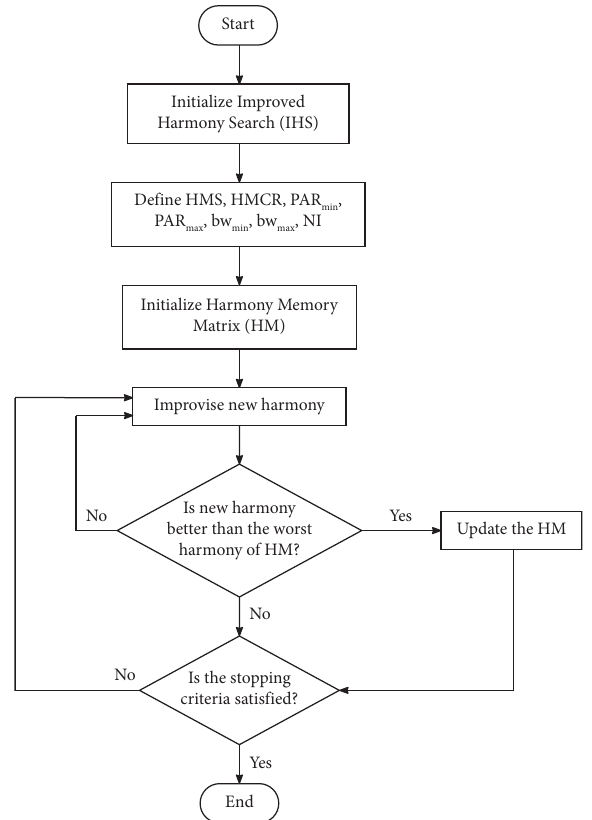
Figure 2: Flowchart of the IHS